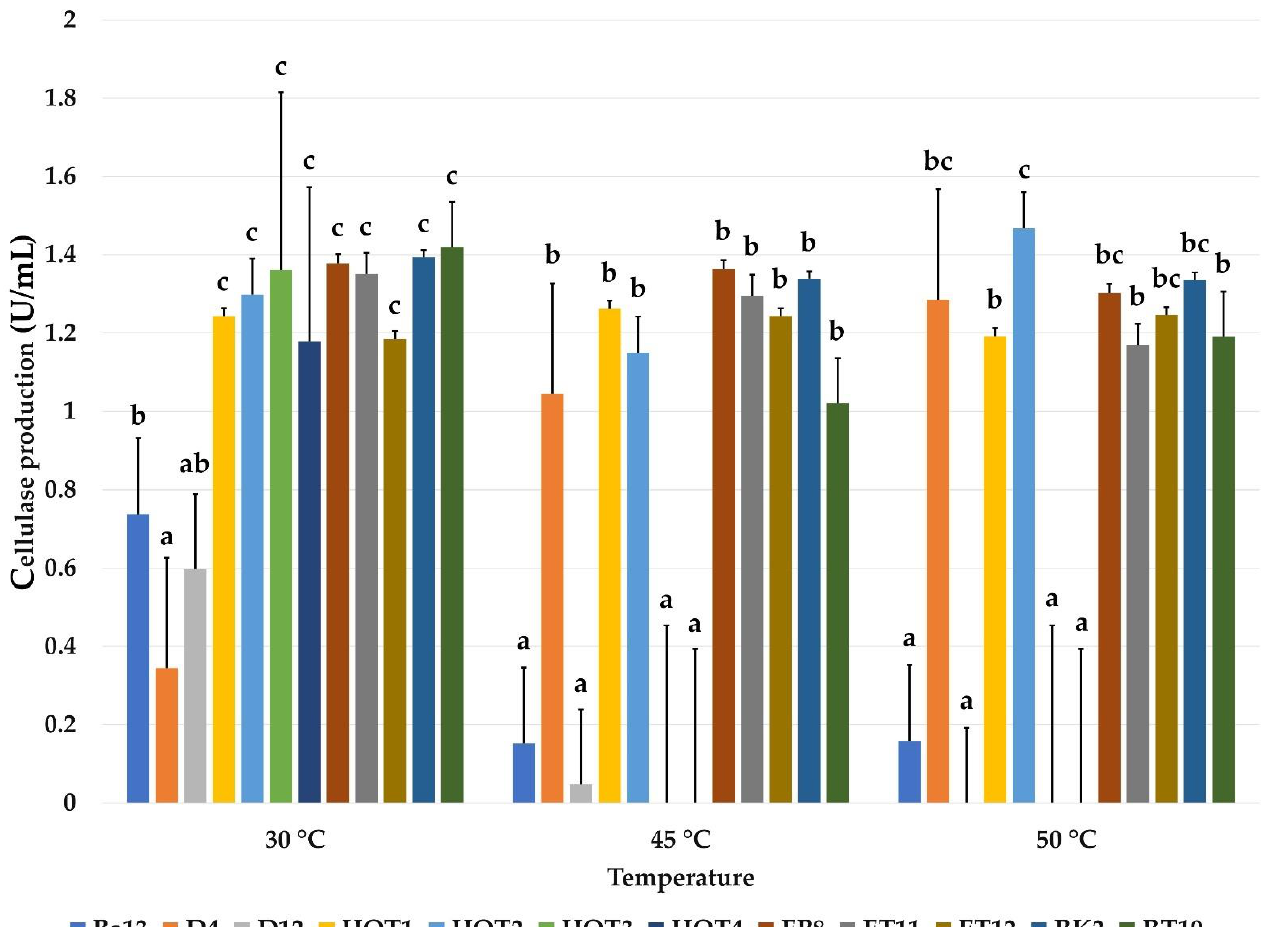
Figure 5. Effect of temperature on the production of CMCase in CMC broth (1%) of the 12 isolates tested. The results are expressed as the mean-standard error of the values of the enzymatic units in duplicate. The production temperature effects corresponding to each treatment and not sharing the same letters are significantly different according to Tukey ’ s post hoc HSD test.